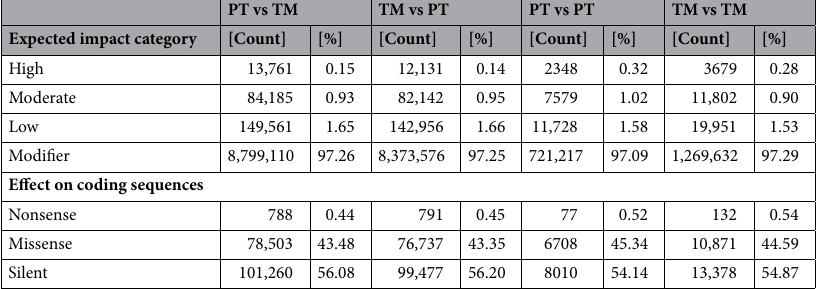
Table 9. Overview on putative effects of intra- and interspecies variants: Shown are variant effect annotations as determined by SNPeff 37 . The numbers represent heterogeneity between species (for PT vs TM and TM vs PT) and heterogeneity within species (for PT vs PT and TM vs TM). These numbers may include the net effect of technical issues (e.g., with assembly, annotation, mapping and calling